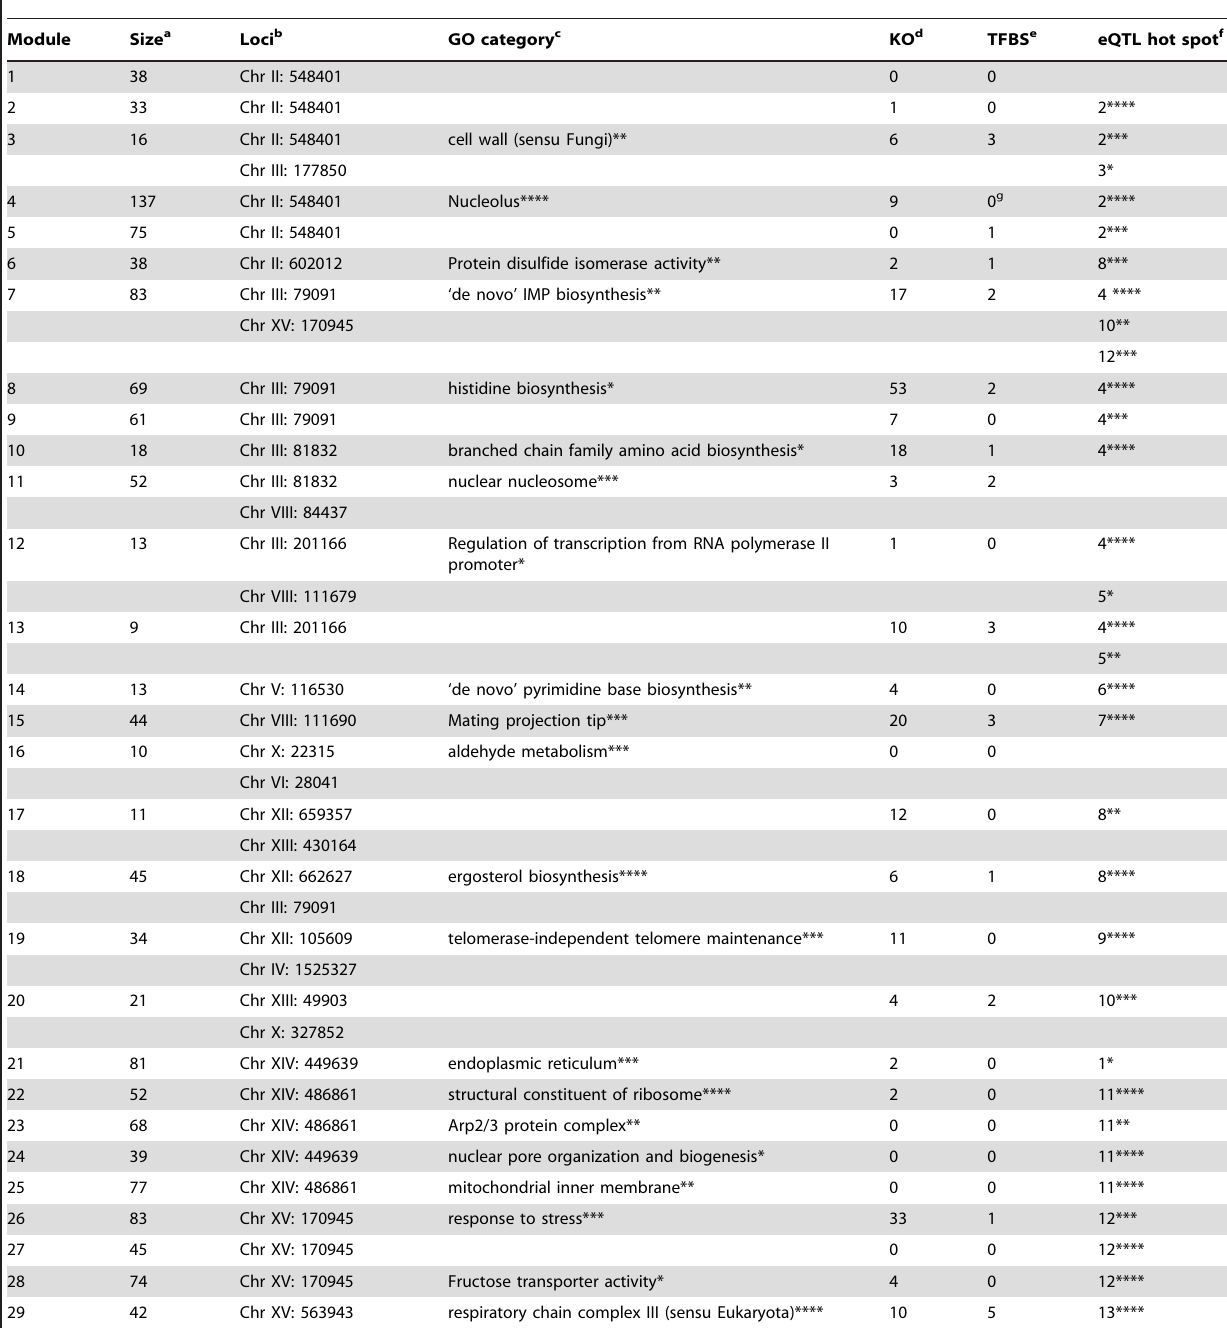
Table 3. Summary of the 29 modules that were detected in the yeast data set.